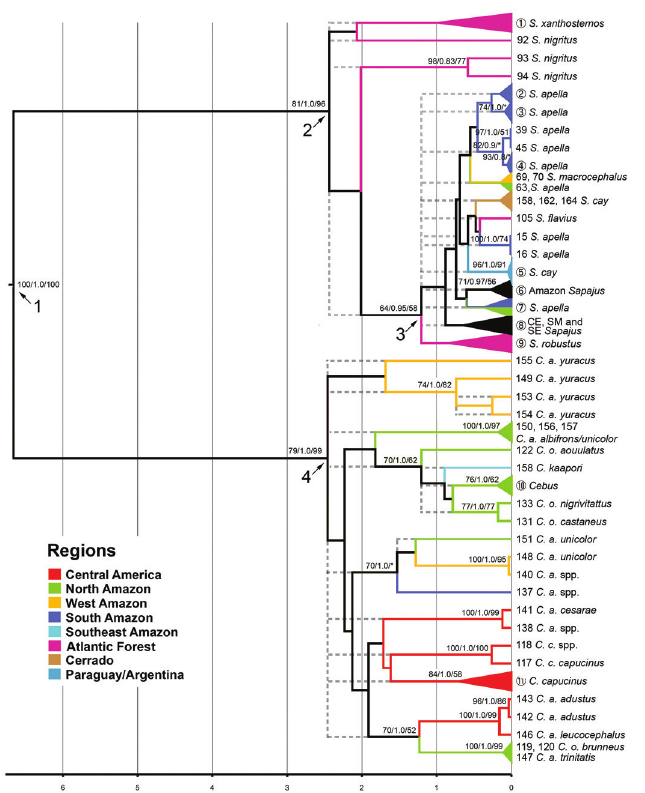
Figure 4 - Maximum Clade Credibility (MCC) gene tree estimated on BEAST 1.8.3 from DS2. Circles with Arabic numbers inside represent collapsed samples (see Table S1). The numbers above the nodes are statistical supports provided by, from left to right, Maximum Likelihood bootstrap, Bayesian credibility and Maximum Parsimony bootstrap. The dots show the polytomy in both genera. The meaning of arrows 1, 2, 3 and 4 is described in Figure 3. Except for the nodes indicated by the arrows, only support values greater than 70% are